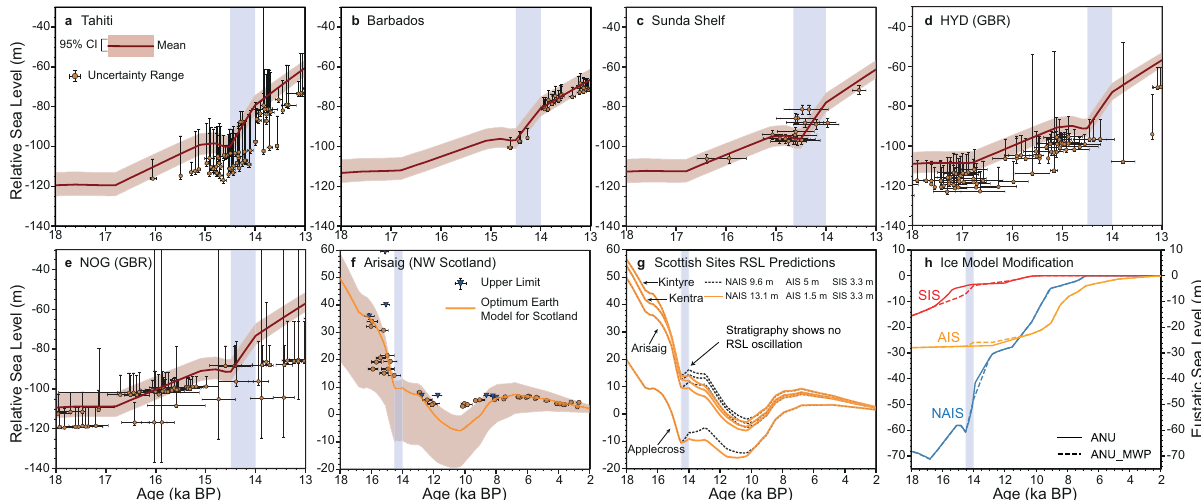
Fig. 4 RSL predictions using the modi fi ed ANU model (ANU_MWP). Error bars show depth range and 2 σ age uncertainties provided by original studies. The blue vertical band indicates the duration of MWP-1A assumed in the ANU ice model (14.5 – 14.0 ka BP). f Orange solid line indicates the RSL prediction generated using the optimum Earth model (65 km lithospheric thickness, 4/200 × 10 20 Pa s upper/lower mantle viscosity) instead of the ensemble mean as in ( a – e ). By combining our MWP-1A solution with this optimum Earth model in Scotland, we achieve a good fi t to RSL data and meanwhile avoid a local RSL oscillation. g RSL predictions for four Northwest Scotland sites generated using the optimum Earth model in combination with two MWP-1A scenarios: one that uses the ensemble mean inversion result of this study (orange solid lines) and one where the AIS contributes 5 m to MWP-1A (black dashed lines). The isolation basin stratigraphies indicate no RSL oscillation in Northwest Scotland during MWP-1A. h Ice history modi fi cations, solid and dashed lines represent the ANU and ANU_MWP model, respectively. Note the different